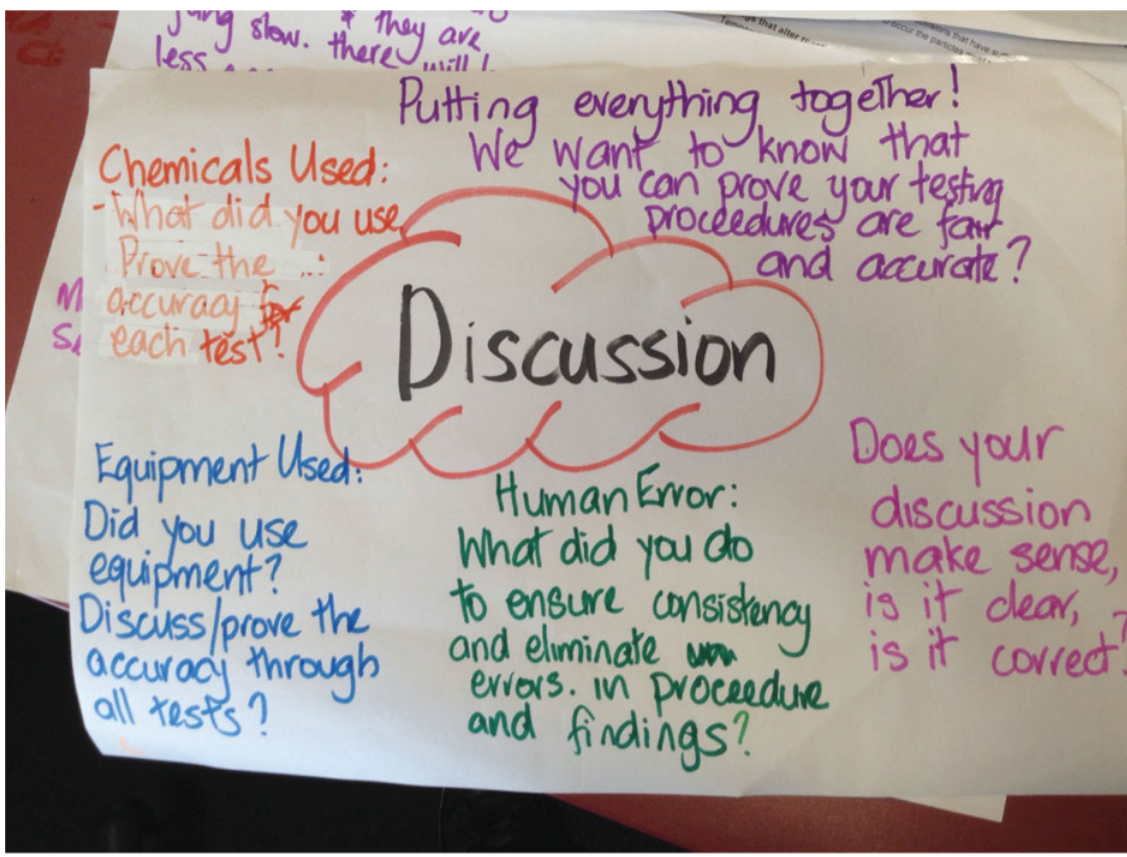
Collaborative learning about what to include in a